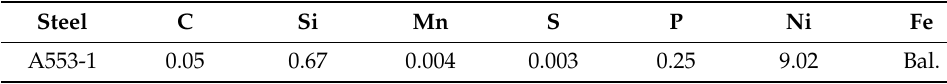
Table 1. Chemical composition of steels used (wt. %).